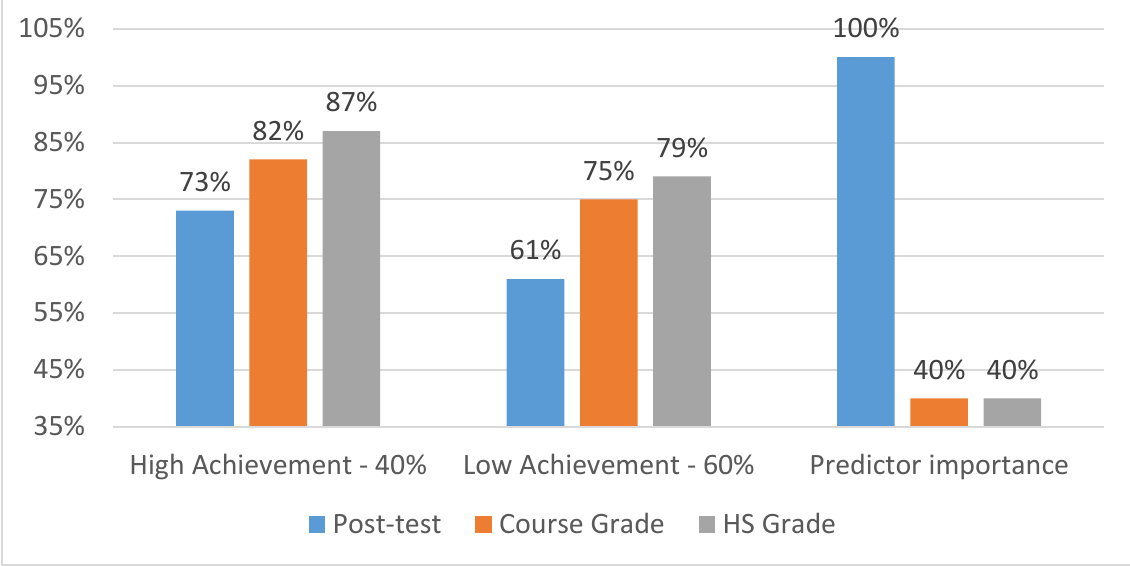
FIGURE 11. CHARACTERISTICS OF ACHIEVEMENT GROUPS 1010 B AND